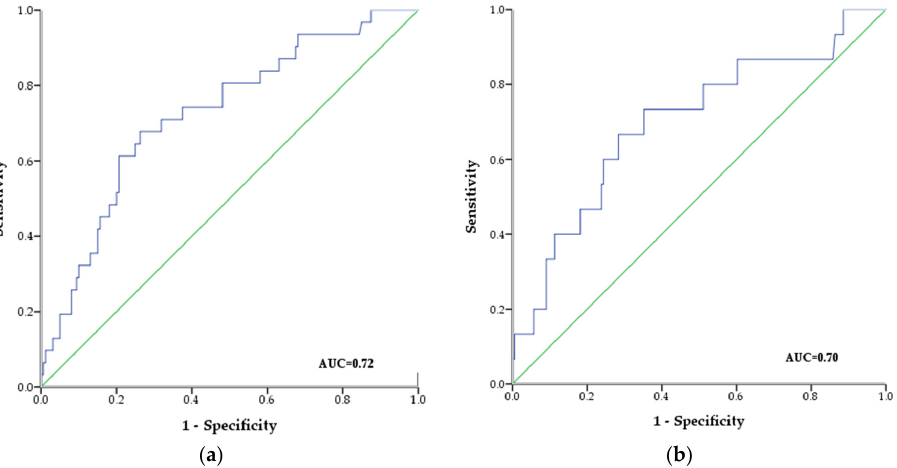
Figure 2. ( a ) ROC curve of OPG for all-cause mortality (AUC 0.72, CI 95%: 0.627–0.821), cut-off point for OPG = 14.37 pmol/L, p < 0.001; with 72.4% sensitivity and a specificity of 62.5%. ( b ) ROC curve of OPG for CV mortality (AUC: 0.70; CI 95%: 0.552–0.845), cut-off point for OPG = 13.57 pmol/L, p < 0.011, with a sensitivity of 77.3% and a specificity of 64.8%. Figure 3a shows the association of OPG concentration with all-cause mortality (Cox